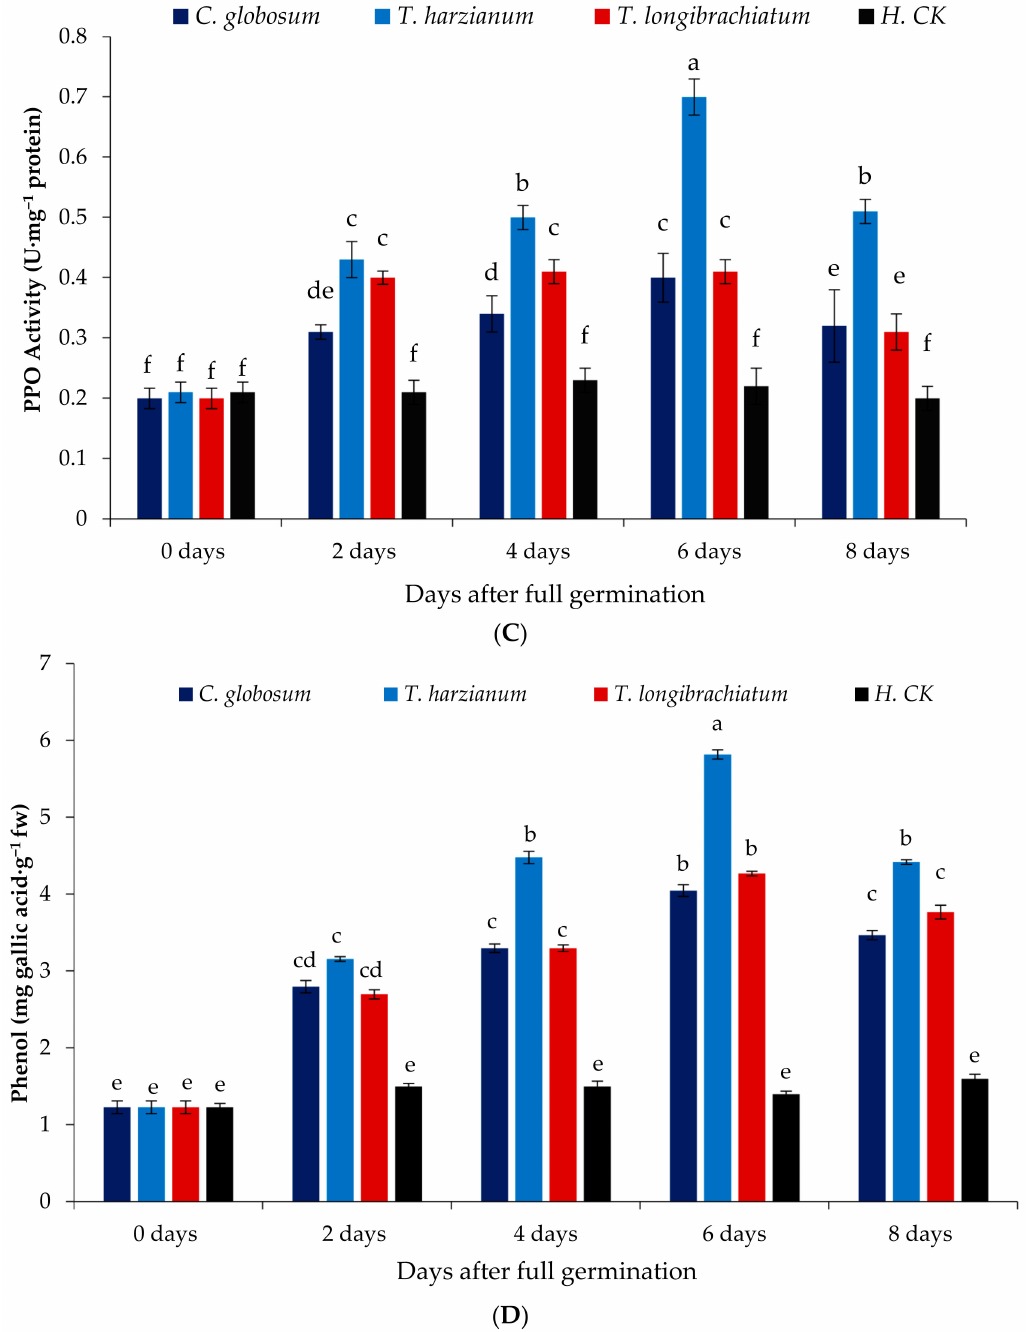
Figure 6. Effect of culture filtrate of fungal endophytic bioagents on the induction of ( A ) peroxidase (PO), ( B ) phenylalanine ammonia-lyase (PAL), ( C ) polyphenol oxidase (PPO), and ( D ) phenol con- tent in cumin plants under greenhouse conditions. Identical letters within each treatment are not significantly different at the p < 0.05 level of confidence according to the least significant difference (LSD) multiple range test. C. globosum , Chaetomium globosum ; T. harzianum , Trichoderma harzianum ; T. longibrachiatum , Trichoderma longibrachiatum ; H. CK, healthy